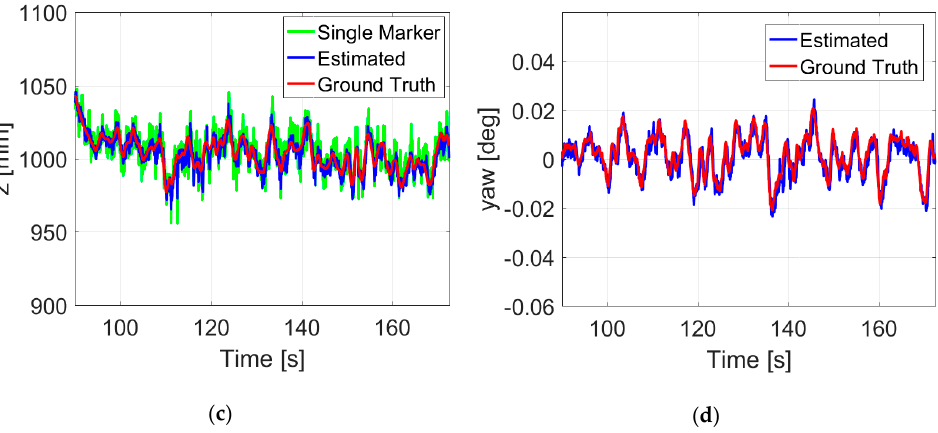
Figure 12. Position ( a,b,c ) and yaw angle ( d ) estimates during a hovering flight at 1 m height.